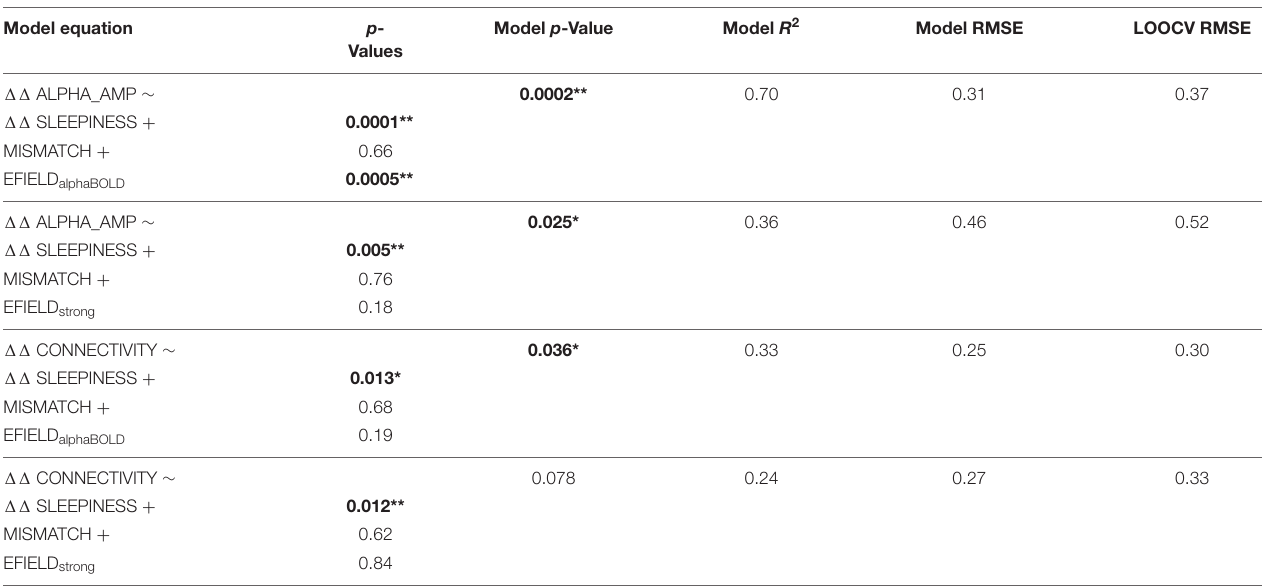
TABLE 2 | Results of the multiple linear regression